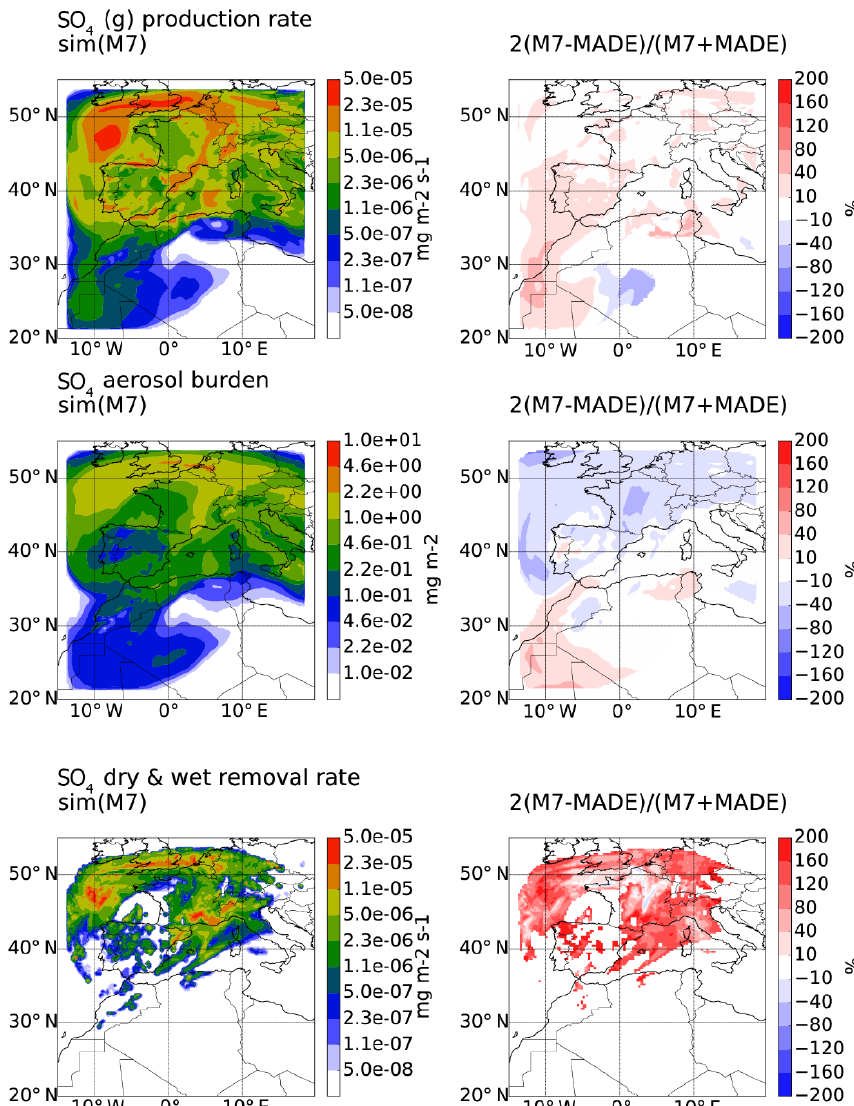
Figure 4. Sulfate budget for sim simulations. Comparison of M7 (left column) to MADE (percentage-difference plots in the right column) in terms of the vertical integral of the gas-phase production rate of SO 4 (first row), sulfate burden (second row), and the sum of dry deposition and vertically integrated impaction scavenging rate of sulfate (last row). See Fig. 3 for plot